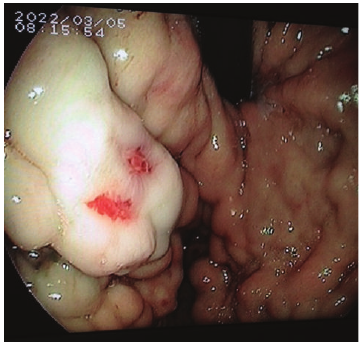
Figure 1: Upper gastrointestinal endoscopy showing extensive gastric varices.